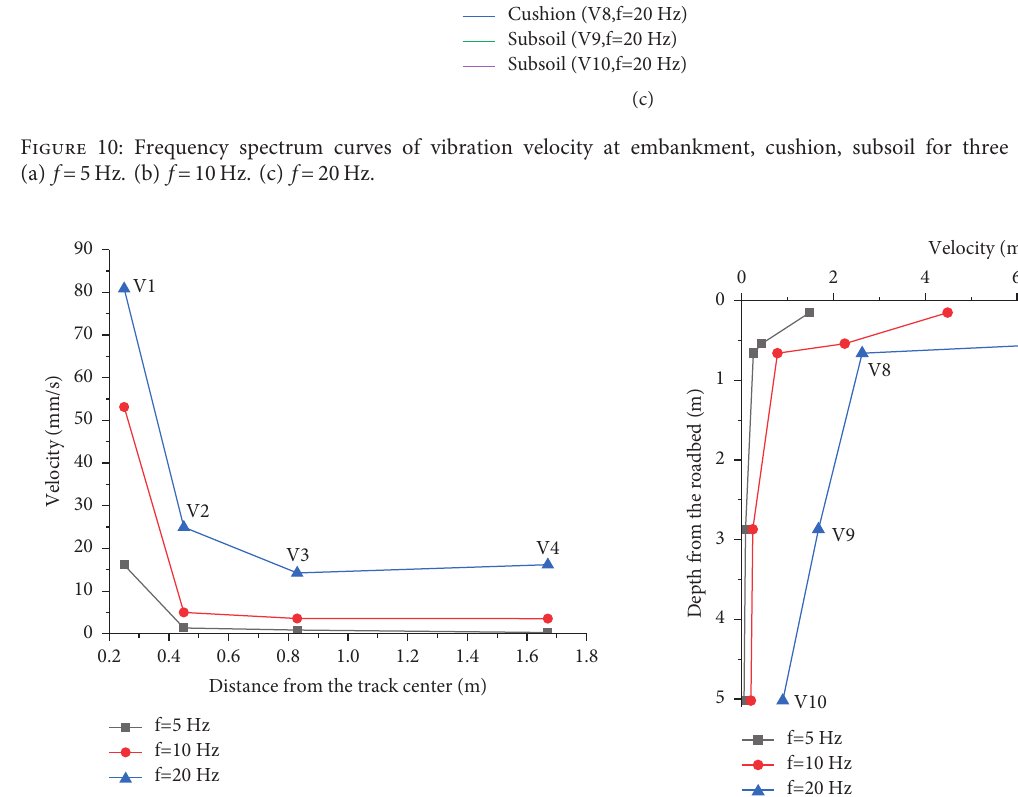
Figure 11: Distribution of vibration velocity in the horizontal direction from the track center ( f � 5 Hz, 10Hz, 20Hz).